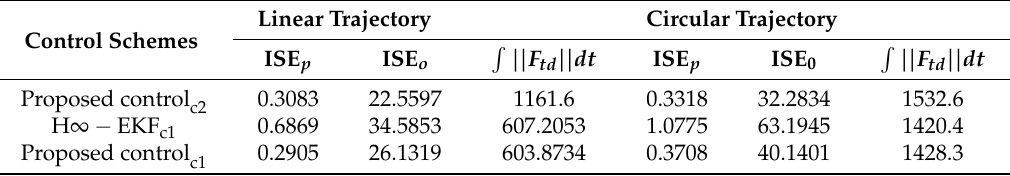
Table 6. Performance analysis of the UVMS for the linear and circular trajectories tracking. Control